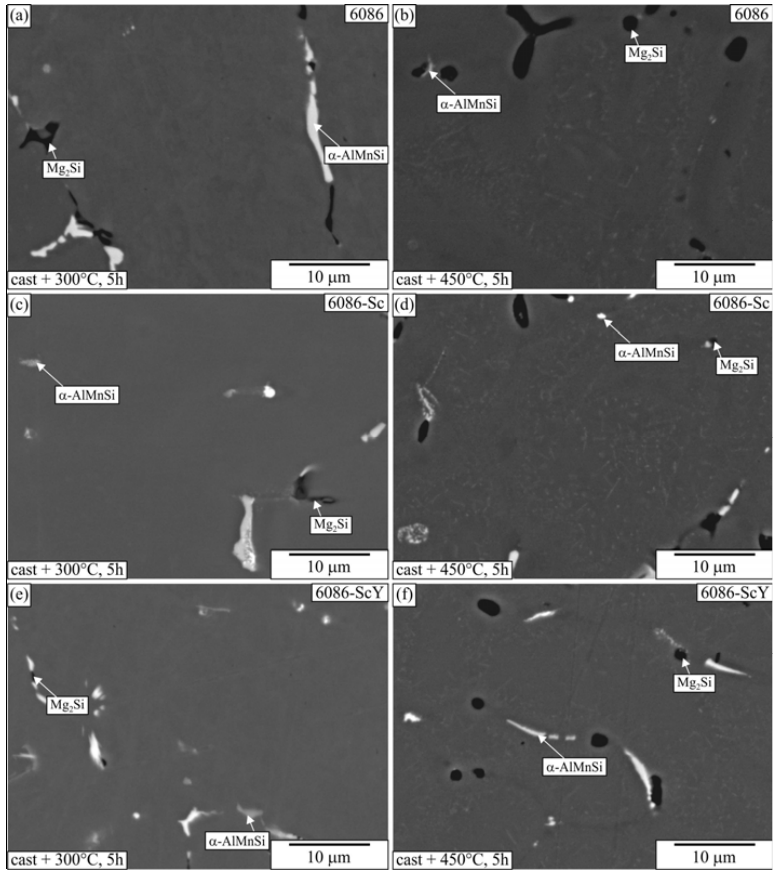
Figure 18. Microstructures of the investigated alloys after T5 heat treatment of the as-cast samples for 5 h at 300 and 450 °C (backsca tt ered electron micrographs, sample diameter 10 mm). ( a ) Alloy 6086, 300 °C, ( b ) 6086, 450 °C, ( c ) 6086-Sc, 300 °C, ( d ) Alloy 6086-Sc, 450 °C, ( e ) 6086-ScY, 300 °C, ( f ) 6086-ScY, 450 °C. 6086, 300 ◦ C, ( b ) 6086, 450 ◦ C, ( c ) 6086-Sc, 300 ◦ C, ( d ) Alloy 6086-Sc, 450 ◦ C, ( e ) 6086-ScY, 300 ◦ C, ( f ) 6086-ScY, 450 ◦